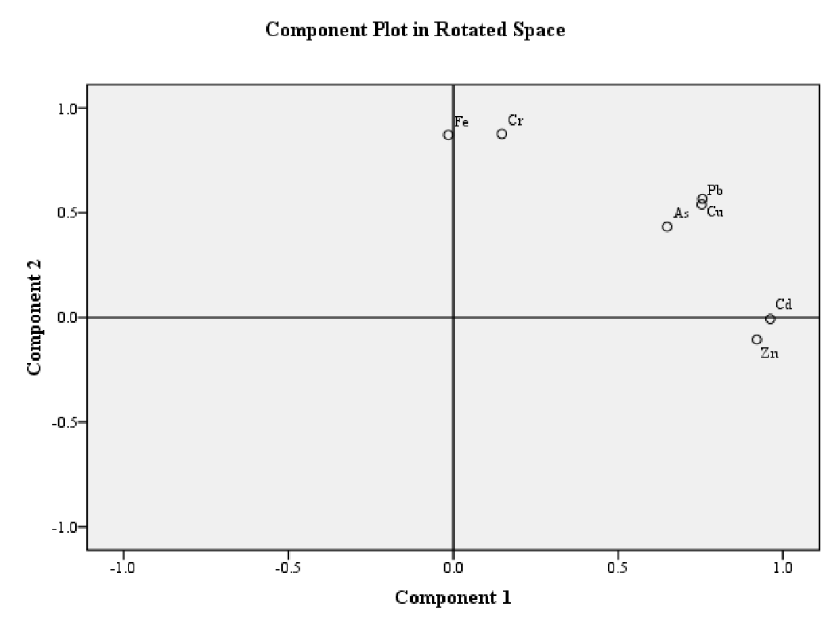
Figure 5. Principal components 1 and 2 of heavy metals in Manwan (M) and Dachaoshan (D) cascading dams.